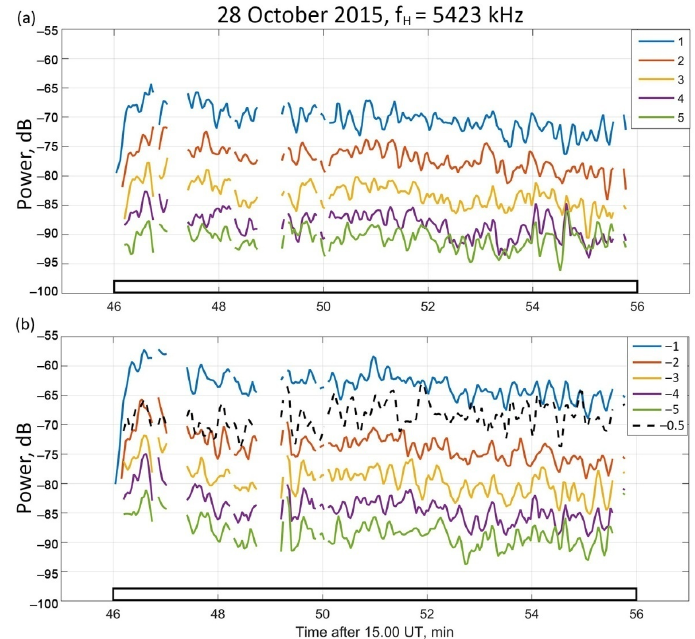
Figure 3. Behavior of intensities for ( a ) the upshifted from the first to the fifth (labeled as 1, 2, 3, 4, 5 and ( b ) downshifted ion gyro-harmonic structures (labeled as − 1, − 2, − 3, − 4, − 5 and − 0.5) in the course of pump pulse from 15:46 to 15:56 UT. Gaps in the intensities of the ion gyro-harmonic structures correspond to the presence of interference. Figure 4 shows the behavior in time of spectral widths for every upshifted and downshifted and ion gyro-harmonic structure (Figure 4a,b respectively) in the course of the pump pulse from 15:46 to 15:56 UT. The spectral width of every discrete structure was determined as the frequency band containing 50% of spectral power. It is clearly seen that increasing the harmonic number from the first to the fifth leads to a rise of spectral width from 6 to 17 Hz.